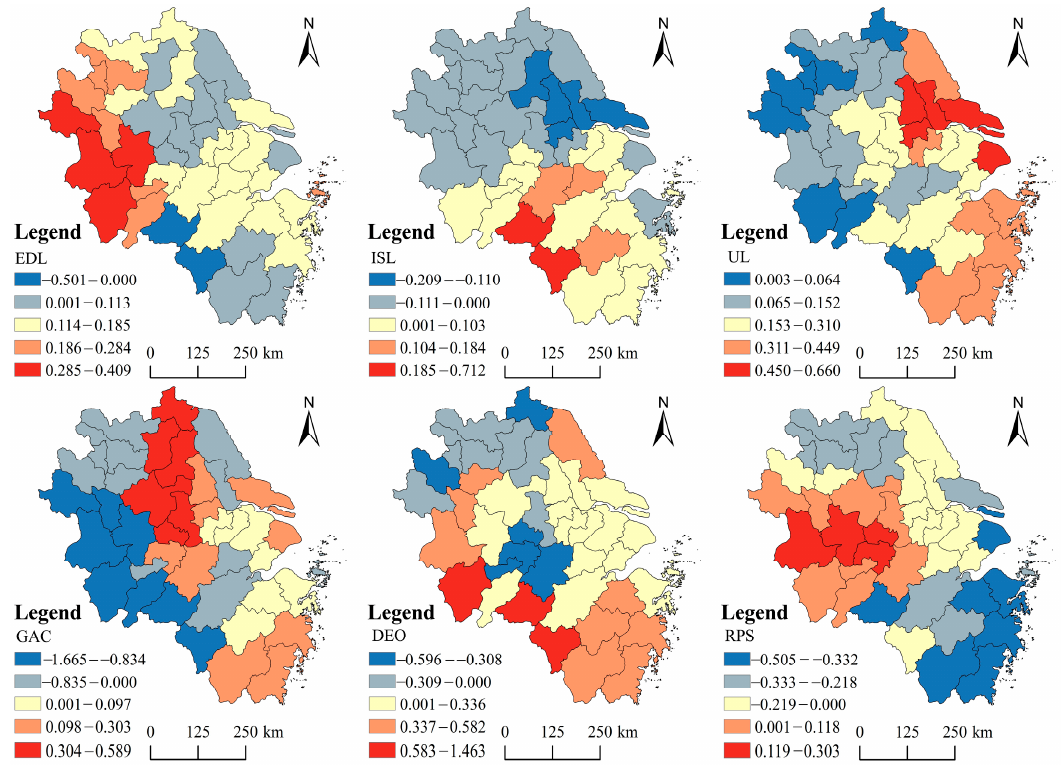
Figure 9. Spatial distribution of mean values of regression coefficients for each impact factor, 2010–